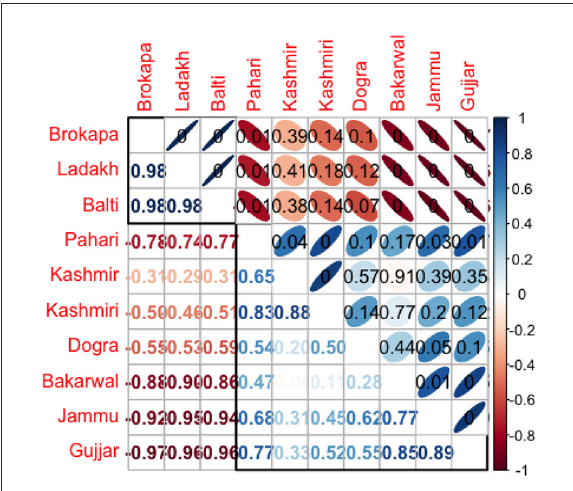
FIGURE9 Cluster diagram of the different provisioning services based on plant usage pattern in different regions.